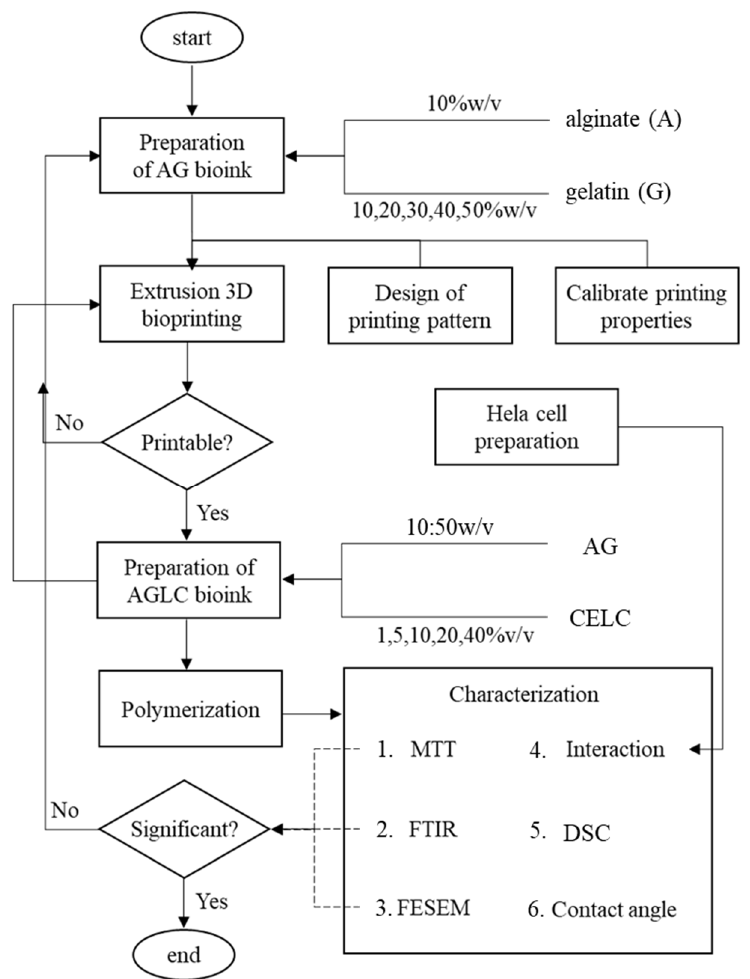
Figure 1. The flow chart of the research activities. The top part of the figure includes the printability of AG hydrogel. The middle part includes the printability of the AGLC bioinks. The bottom part of the figure shows the characterization of the AGLC bioinks.